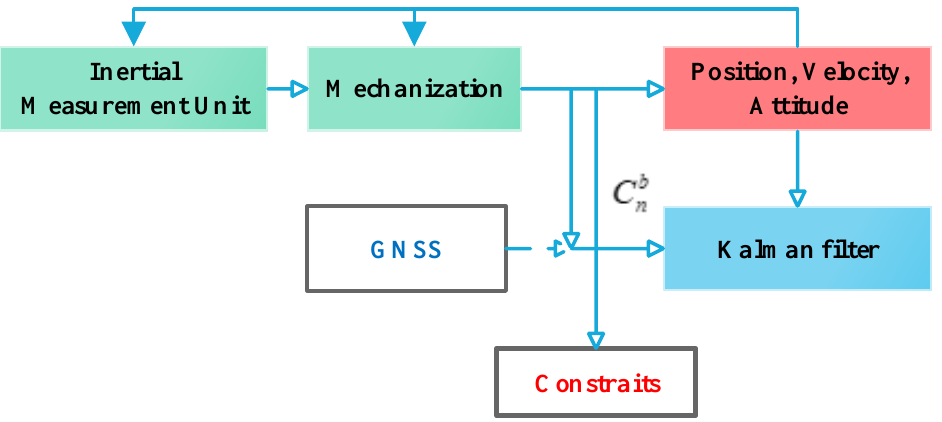
Figure 2. Structure of the Global Navigation Satellite System (GNSS)/Inertial Navigation System (INS)/odometer/Non-Holonomic Constraints (NHC) integrated system.